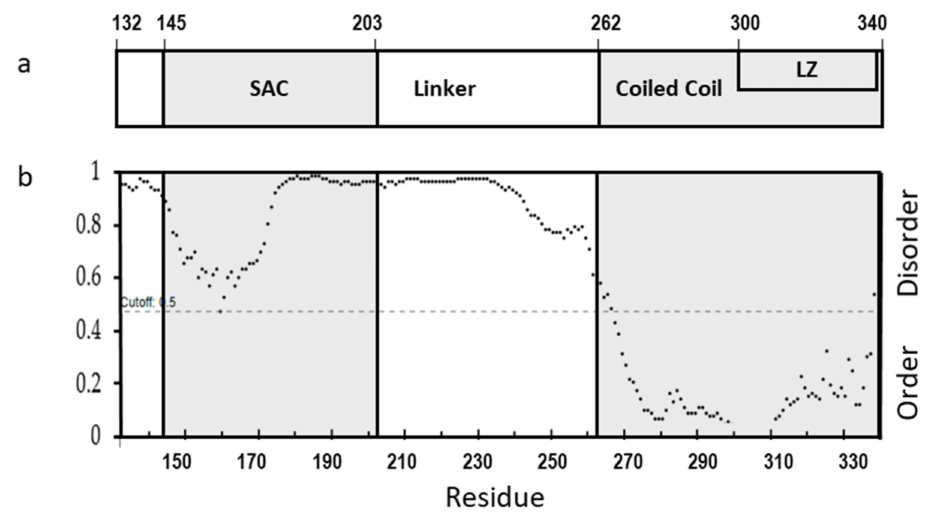
Figure 1. ( a ) Schematic diagram showing domains of cleaved Par-4 protein (cl-Par-4) and ( b ) Disorder prediction in cl-Par-4 using